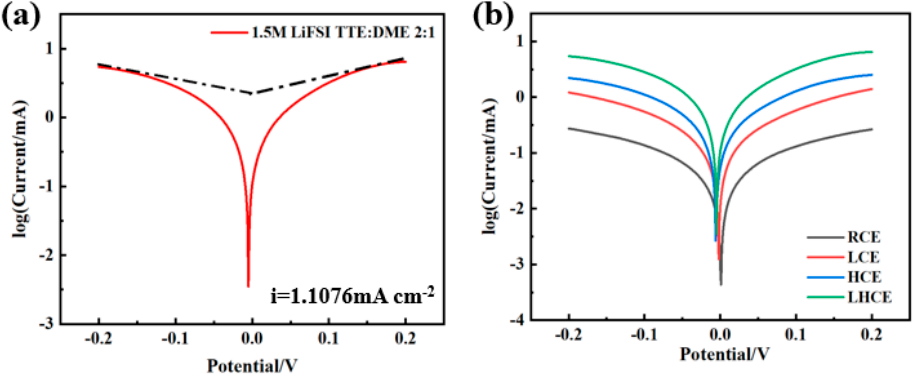
Figure 4. Tafel curves of Li||Li batteries ( a ) in LHCE, ( b ) in the four